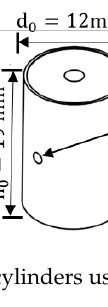
Table 2. Chemical composition of the experimental alloys in wt.%.